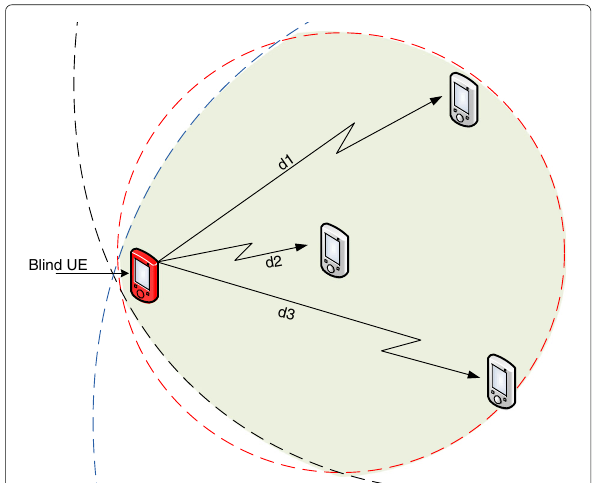
Fig. 11 Measurement incertitude model. This figure represents a location zone for blind UE called measurement incertitude zone, where the white UE are the already localized ones and the red one represents the blind UE